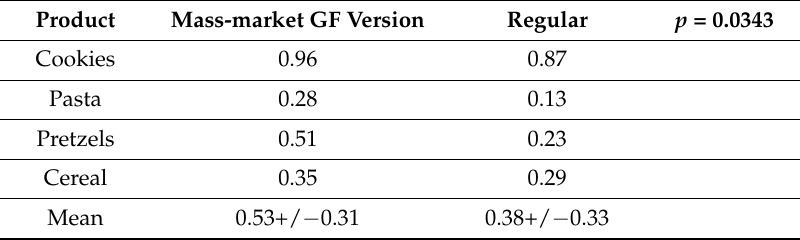
Table 1. Cost of mass-market GF products in 2016 compared to wheat-based products in price per